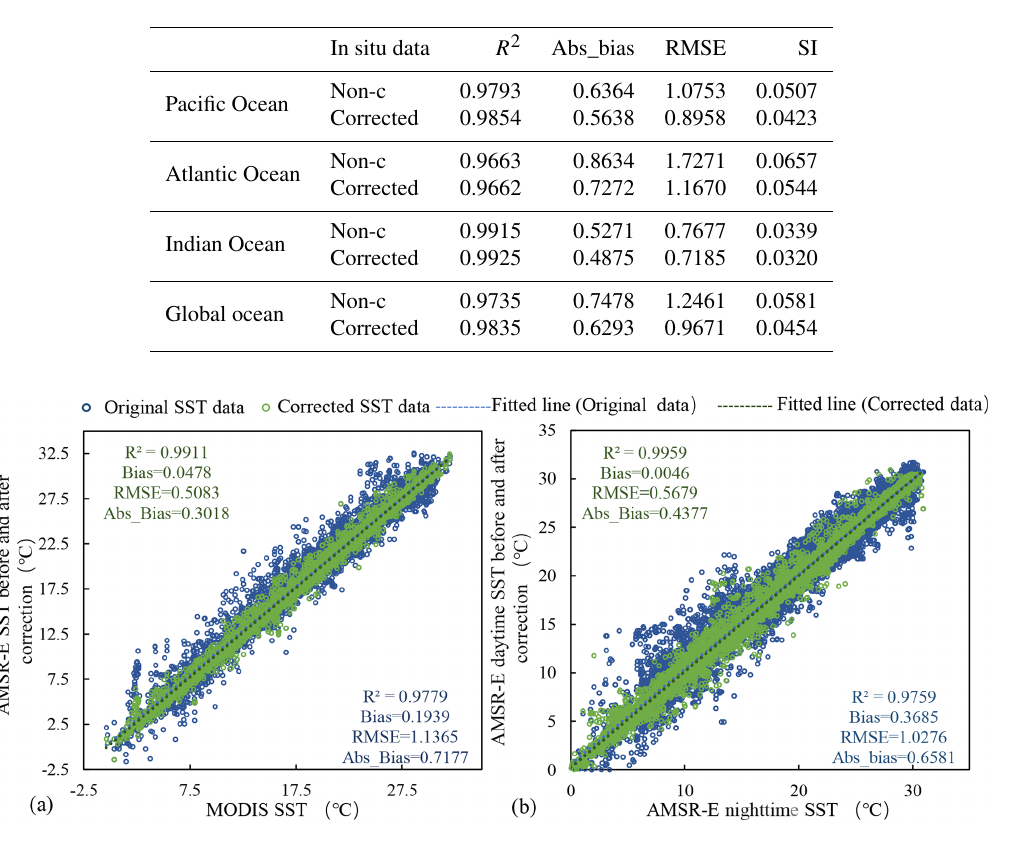
Figure 12. The scatter diagrams of the daily original SST data and corrected results versus their corresponding actual SST data from 2002 to 2019. The blue points indicate original SST pixel values. The green points represent the values in corrected SST data, and the statistical accuracy measures ( R 2 , bias, Abs_Bias, and RMSE) are also